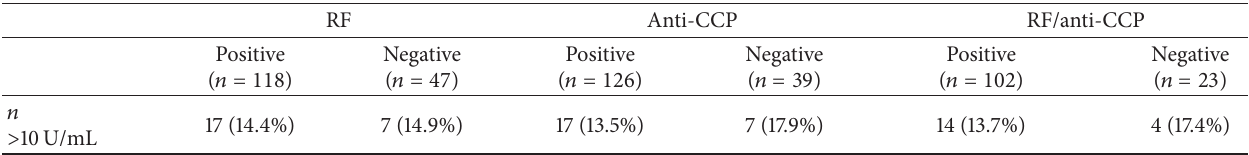
Table 3: Anti-hnRNP B1 autoantibodies in 165 patients with rheumatoid arthritis depending on the presence of rheumatoid factor and anti- CCP antibodies.